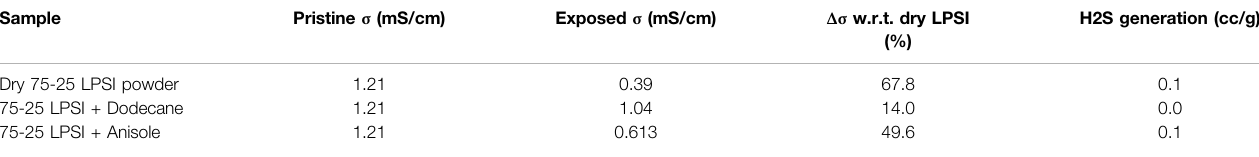
TABLE 3 | Ionic conductivity and H 2 S generation data for LPSI SSE powders exposed to a − 40 ° C dew point dry room environment as a slurry for 30 min. Sample Pristine σ